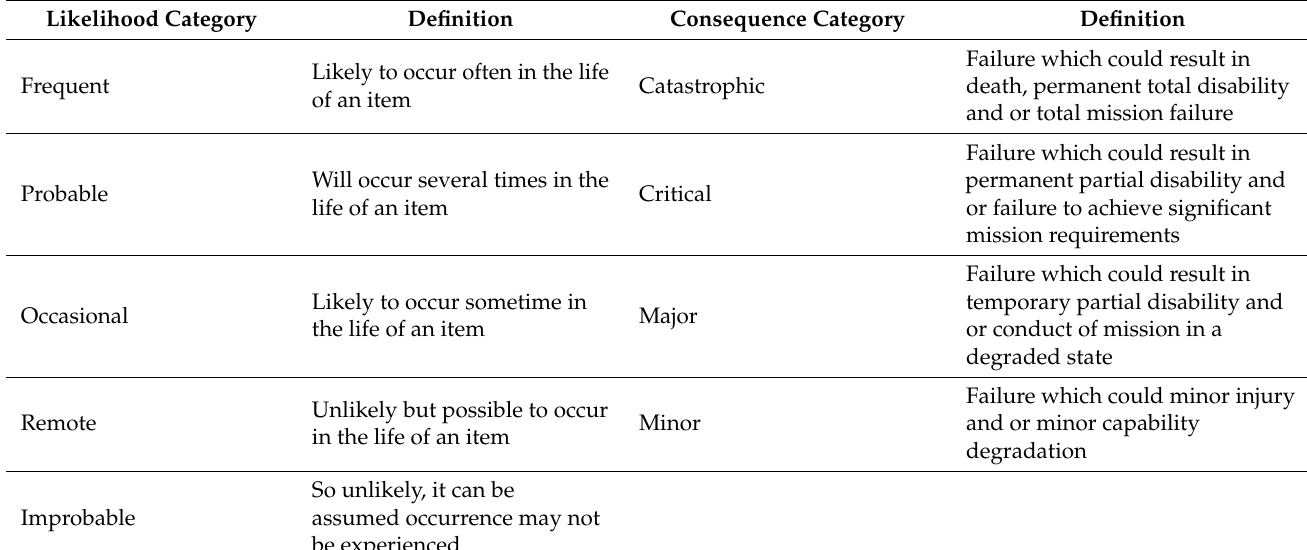
Table 8. Likelihood and Consequence Category